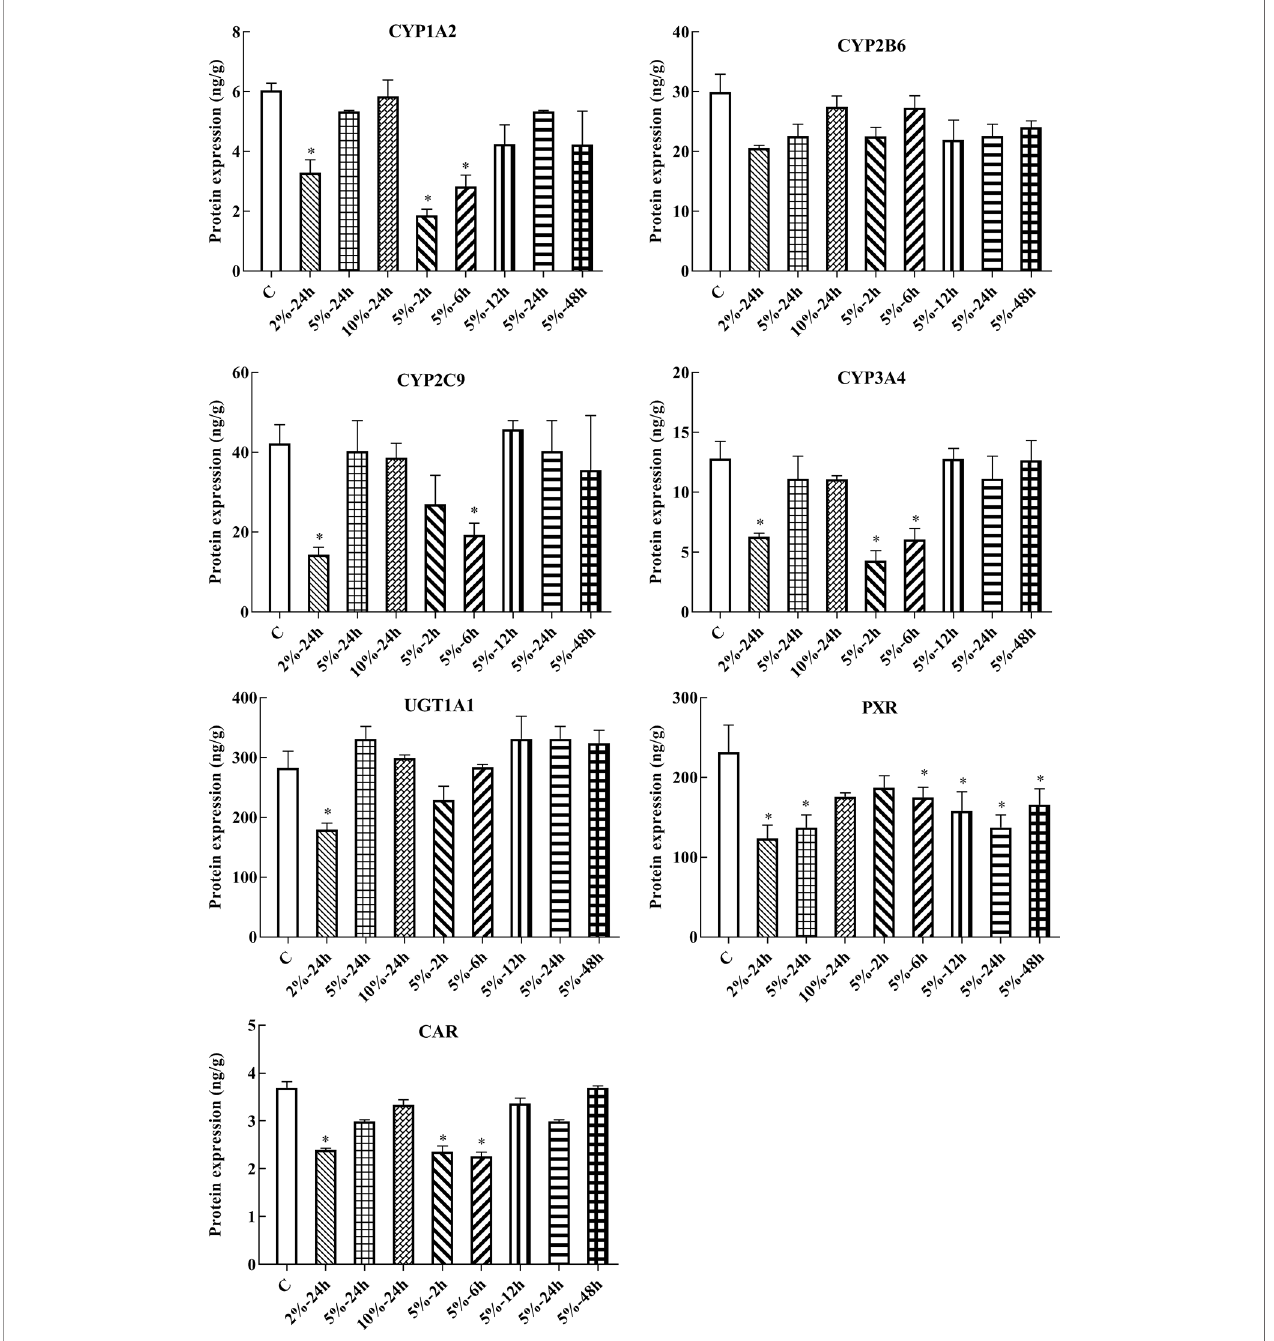
FIGURE 4 | Protein expression of CYP1A2, CYP2B6, CYP2C9, CYP3A4, UGT1A1, PXR, and CAR in HepG2 cells. C, control group, HepG2 cells were cultured in a normoxic humidi fi ed incubator. HepG2 cells were exposure to 2% O 2 for 24 h (2%-24 h), 5% O 2 for 24 h (5%-24 h), 10% O 2 for 24 h (10%-24 h), 5% O 2 for 2 h (5%-2 h), 5% O 2 for 6 h (5%-6 h), 5% O 2 for 12 h (5%-12 h), 5% O 2 for 24 h (5%-24 h), and 5% O 2 for 48 h (5%-48 h). The data were analyzed using a one-way analysis of variance (ANOVA), and the differences between the means of two groups were compared using LSD tests. * indicates the signi fi cance of experimental groups, compared with that of the control. Values are expressed as Mean ± SEM (n = 3). Levels are considered signi fi cant at * p <